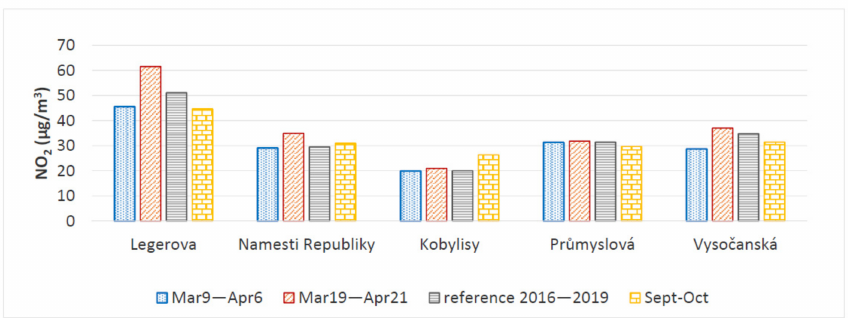
Figure 3. Comparison of monitoring station NO 2 averages during sampling periods with four- year average.